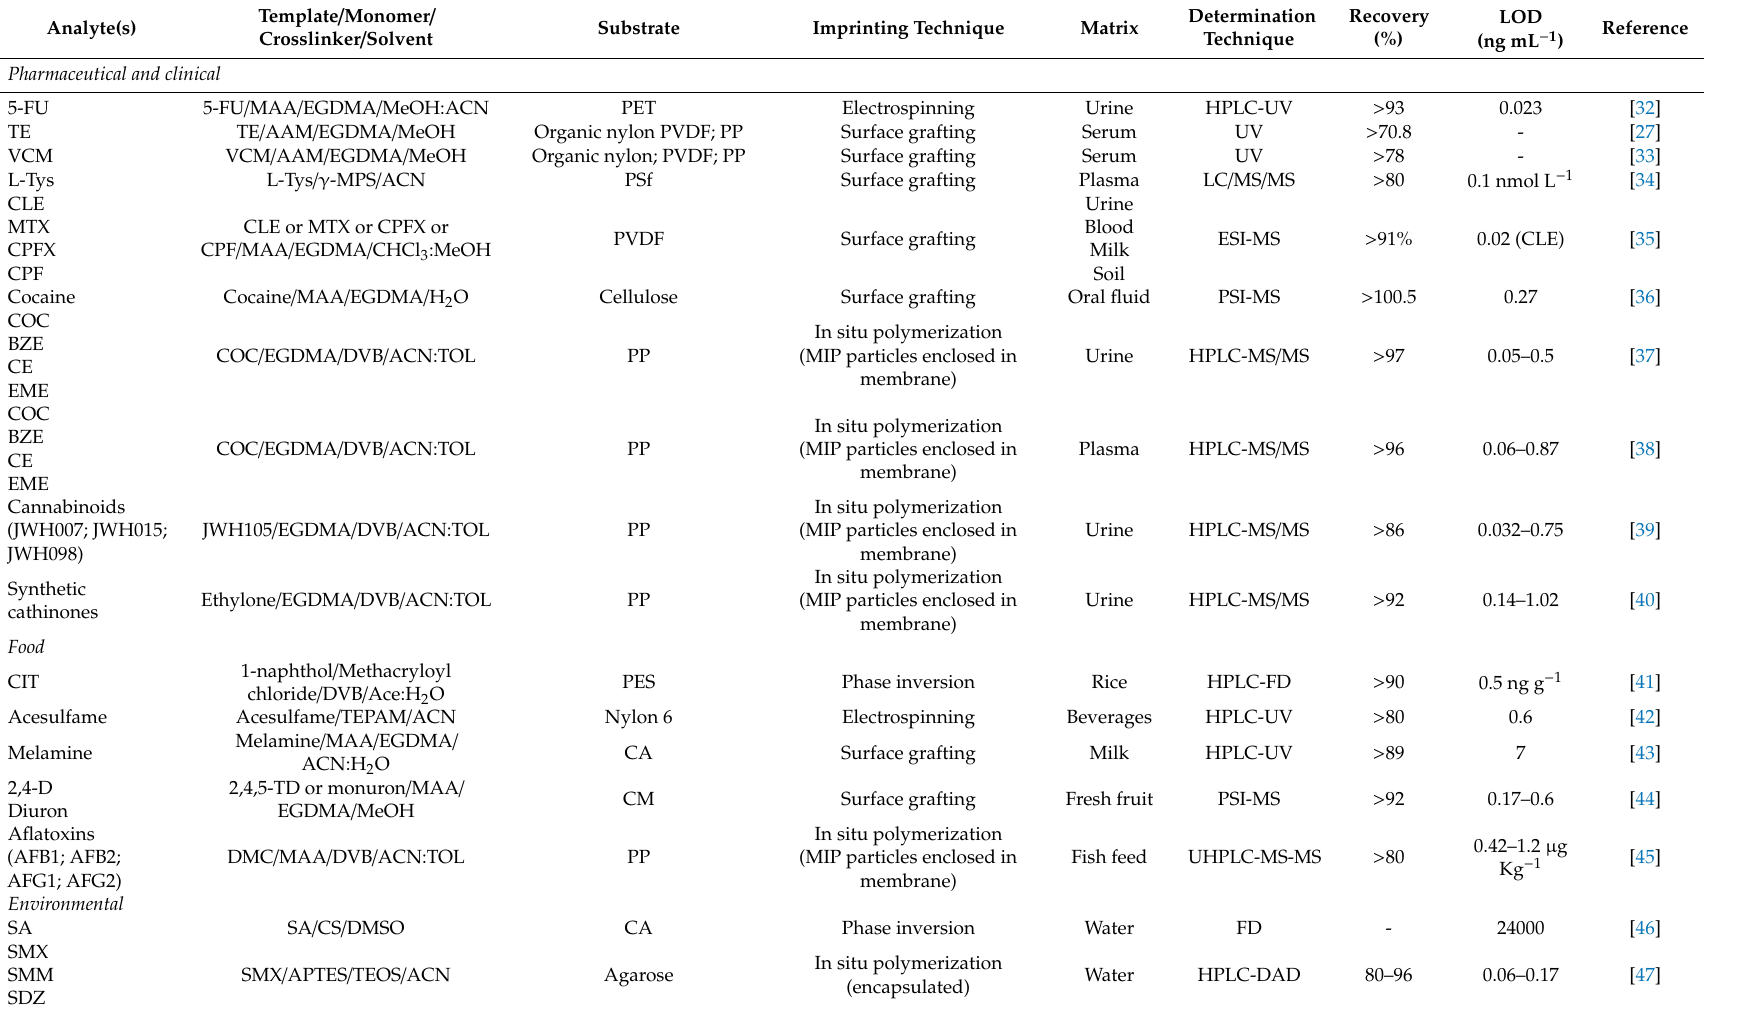
Table 1. Recent MIM-based sorbents for extraction purposes in pharmaceutical, clinical, food and environmental